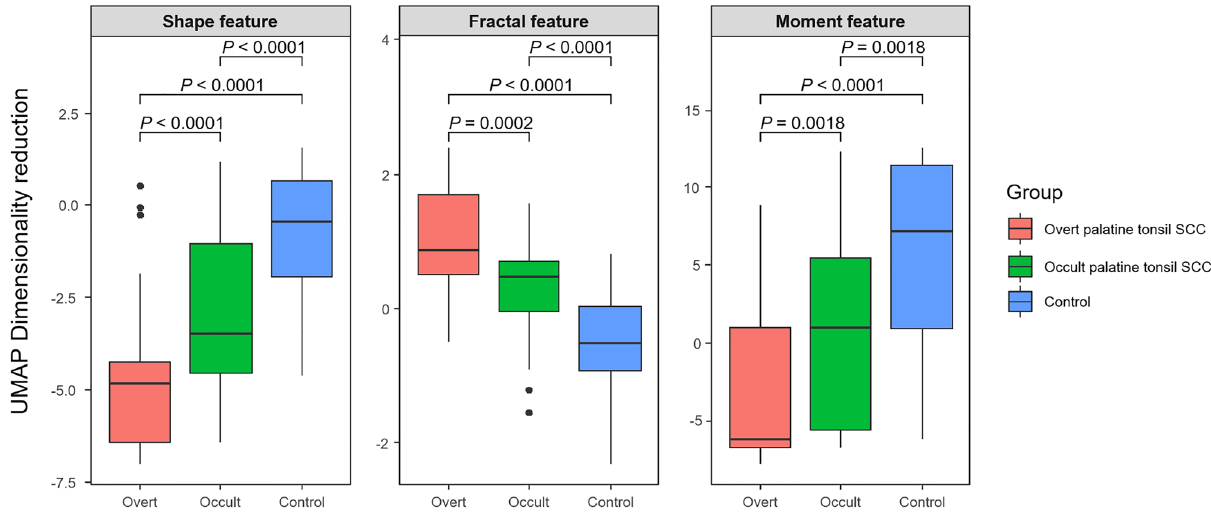
Figure 1. Box and whisker plots of the distribution of the representative values of shape features and fractal analyses in patients with overt palatine tonsil SCC, occult palatine tonsil SCC, and normal palatine tonsils on T2-weighted